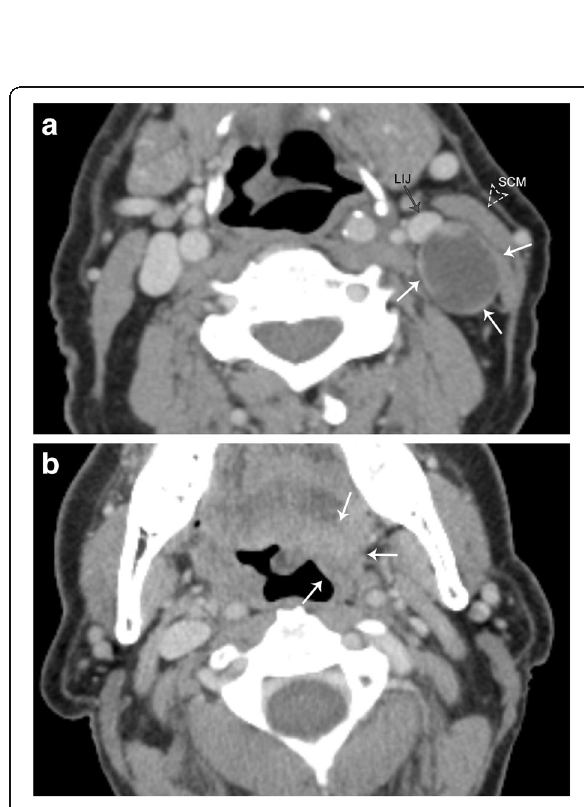
Fig. 21 Cystic metastatic lymph node. Patient presenting with a palpable left neck mass, no other symptoms. a Axial contrast-enhanced CT image demonstrates a well-circumscribed, low attenuation lymph node in the left carotid space (white arrows); note some areas of peripheral nodularity. This node causes mass effect with anterior displacement of the left internal jugular vein (LIJ), and lateral displacement of the sternocleidomastoid muscle (SCM). b Axial contrast- enhanced CT image at a higher level in the same patient demonstrates an ill-defined mass centered at the left tongue base (arrows). Biopsy of this lesion demonstrated squamous cell carcinoma